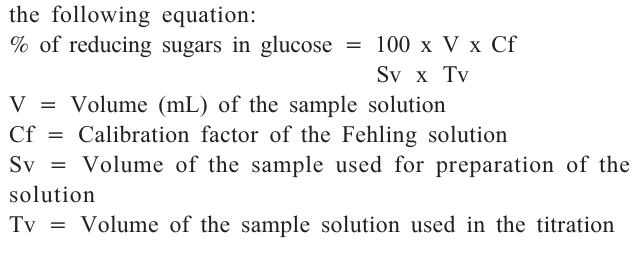
a pH meter (TEC-2R; Tecnal, São Paulo, SP, Brazil). When this value was reached, the spent KOH volume was recorded and the acidic percentage of the substance was calculated using the following equation, with the result being expressed as percentage of citric